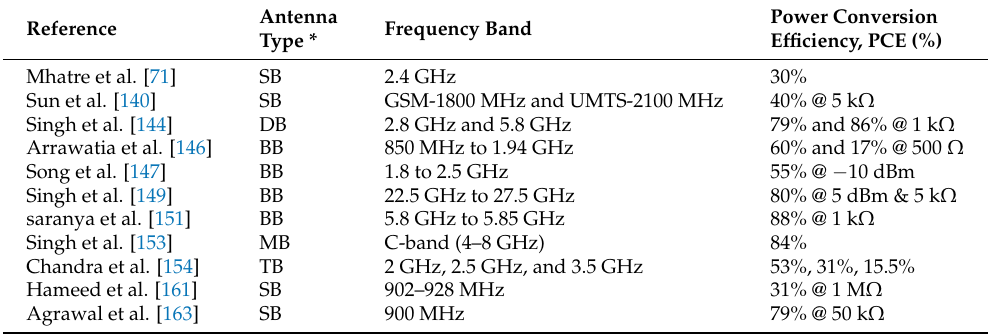
Table 7. Summary of power conversion efficiencies achieved on different frequency bands and loads.